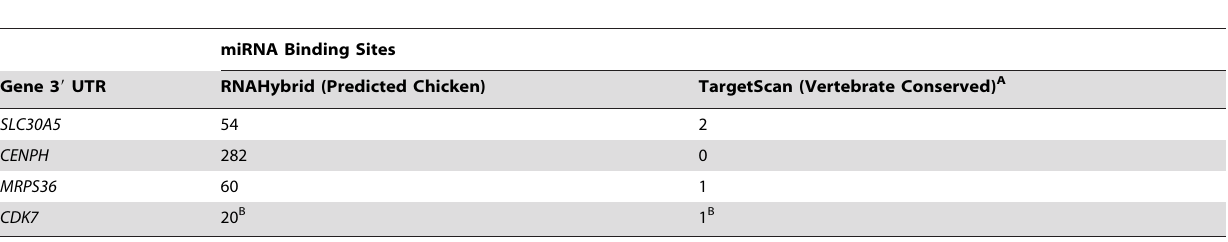
Table 3. Variants within the Co.003 Z co causative region are found within predicted chicken miRNA binding sites.